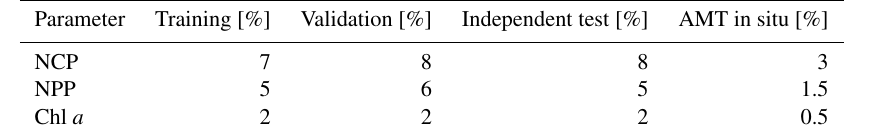
Table 4. The percentage reduction in p CO 2 ( sw ) RMSD by reducing NCP, net primary production and chlorophyll a uncertainties by 10% as described in Sect. 2.5.